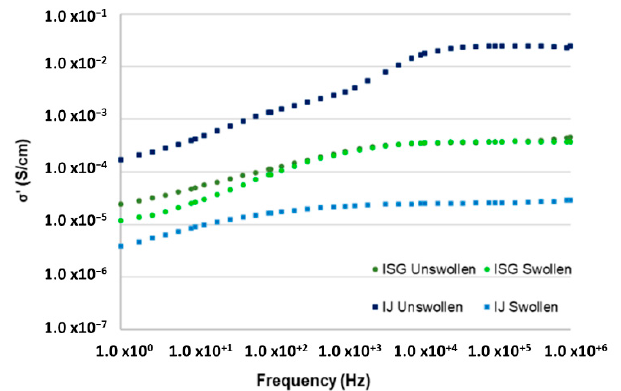
Figure 2. Real part of conductivity for ISG with [omim][TFSI], and IJ made with [emim][EtSO4], at 20 °C. 20 ◦